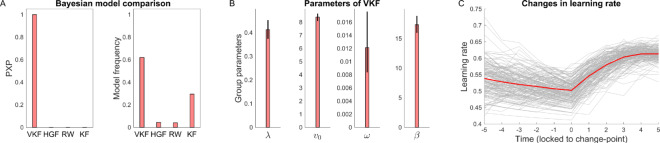
Bayesian analysis of VKF in the second experiment.A) Bayesian model comparison results comparing VKF with HGF, Rescorla-Wagner (RW) and Kalman filter (KF). Similar to the previous dataset, the PXP of the VKF is indistinguishable from 1 (and from 0 for other models) indicating that VKF is the most likely model at the group level. B) Estimated parameters of the VKF at the group-level. C) Learning rate signals, time-locked to the change points, estimated by the VKF for all participants (gray) and the mean across participants (red). The x-axis indicates trials relative to change points. The error-bars in B are obtained by applying the corresponding transformation function on the group-level error-bars obtained by the HBI [35] and, therefore, are not necessarily symmetric.